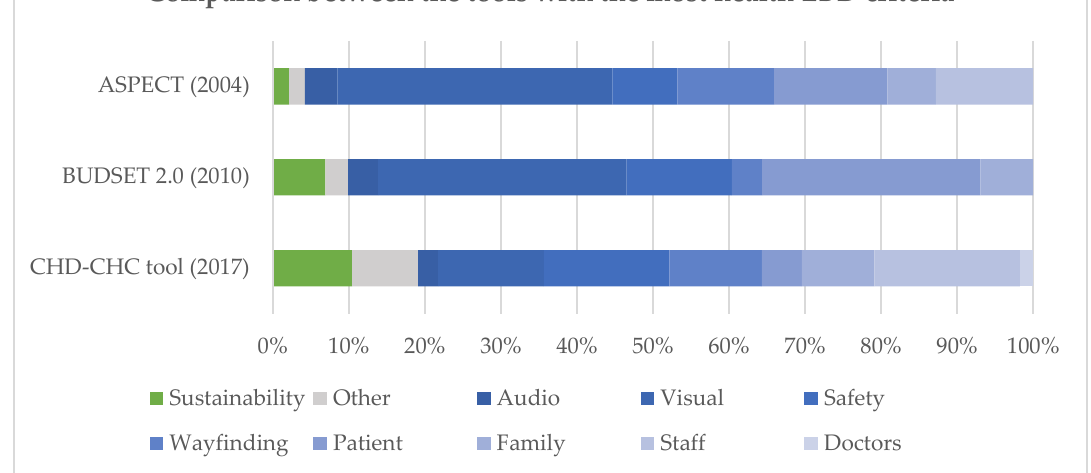
Figure 7. Comparison between the tools that, according to the EBD analysis, have most of the indicators related to health.